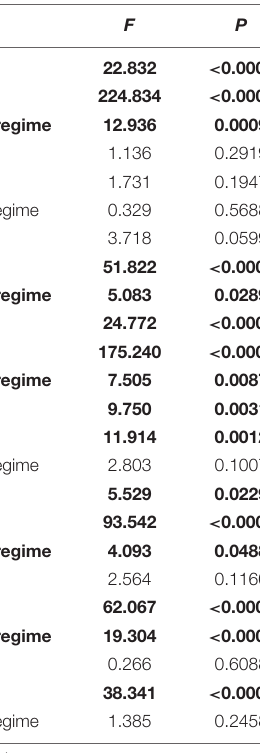
TABLE 1 | Factorial ANOVA on examined oxidative status parameters between the water regime (desiccation and constant water availability), feeding regime (fasting and feeding), and their interaction (water regime × feeding